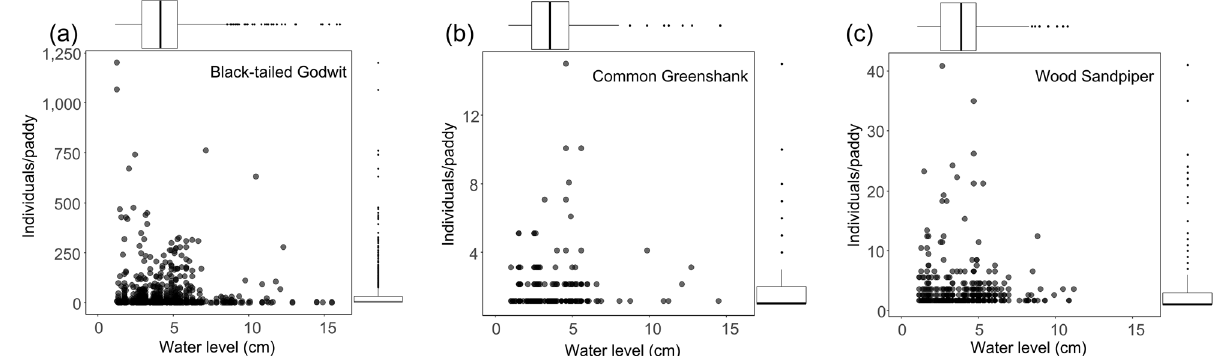
Figure 4. Scatterplot of water level and bird density (individuals/paddy) of shorebirds species. Each variable represents marginal box plots: ( a ) Black-tailed Godwit; ( b ) Common Greenshank; ( c ) Wood Sandpiper.